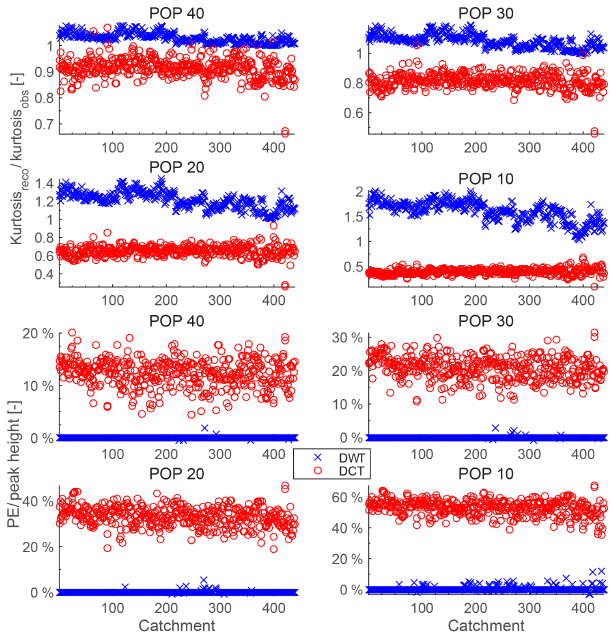
Figure 6. Normalized kurtosis of the reconstructed DWT and DCT signals and percentage PE for the reconstructed DWT and DCT sig- nals for each catchment using a different